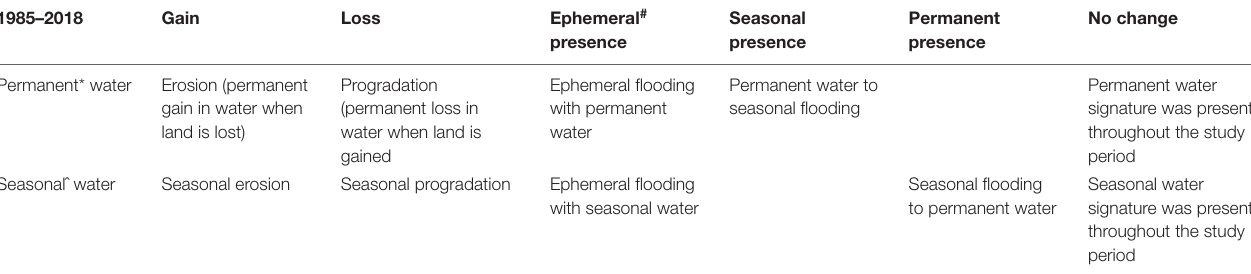
TABLE 4 | Shoreline retreat classes [*Permanent—Water signature is present in all the months for the 35 years analysis period, ˆSeasonal—reoccurrence of water within a year, in other words, presence of water for less than 12 months each year for the 35-year analysis period, # Ephemeral- water signature present for any given time during the 35-year analysis period, adopted from Pekel et al.